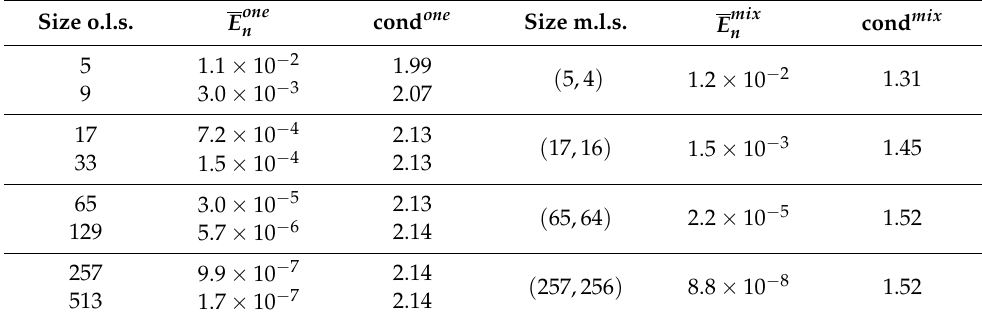
Table 3. Example 2: Ordinary and Mixed Collocation methods [4]. Size